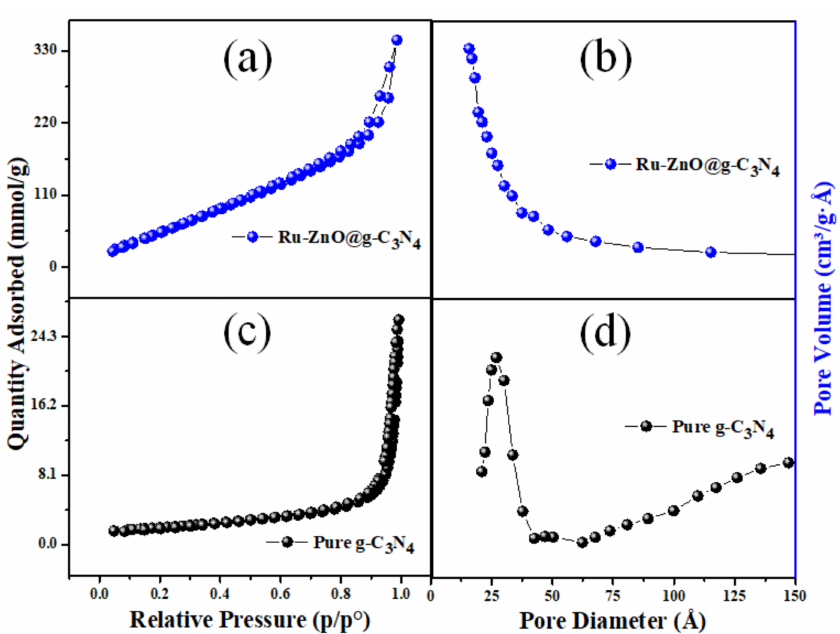
Figure 4. N 2 adsorption-desorption isotherms ( a , c ) pore radius distribution ( b , d ) of pure g-C 3 N 4 and Ru-ZnO@g-C 3 N 4 photocatalysts.